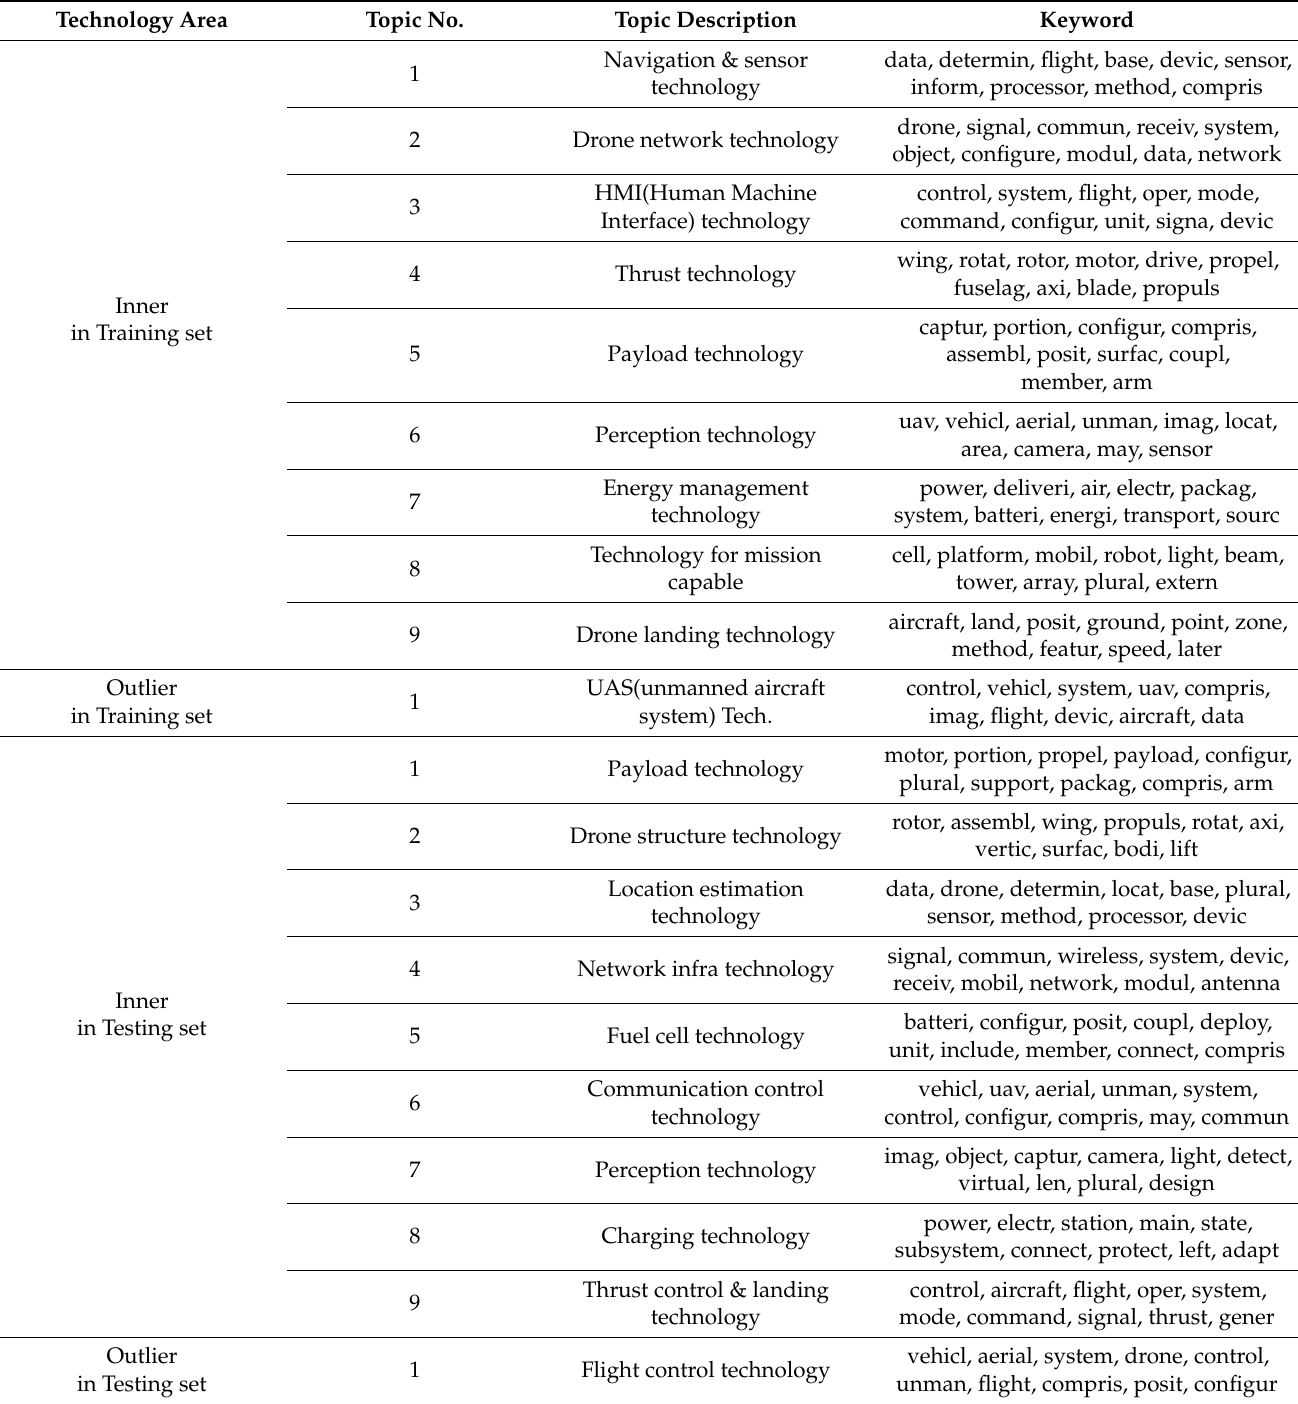
Table 8. Result of the topic